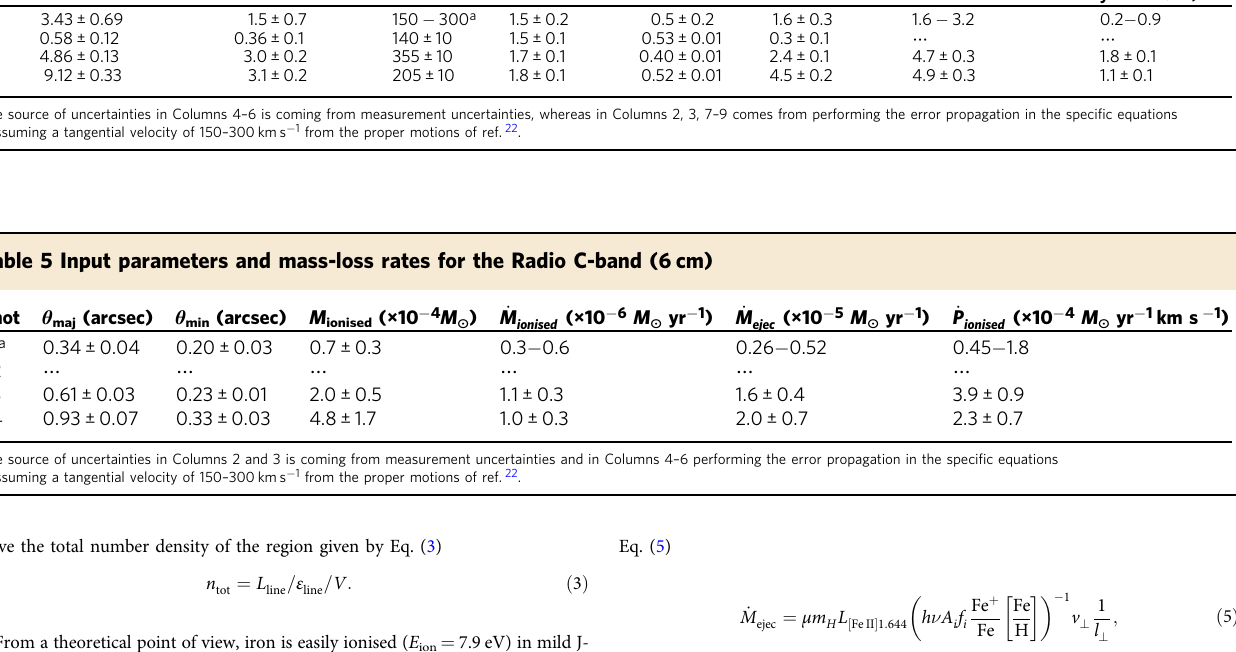
Table 4 Input parameters and mass-loss rates for the [Fe II] 1.644 μ m line Knot L [Fe II] (×10 32 ergs − 1 )